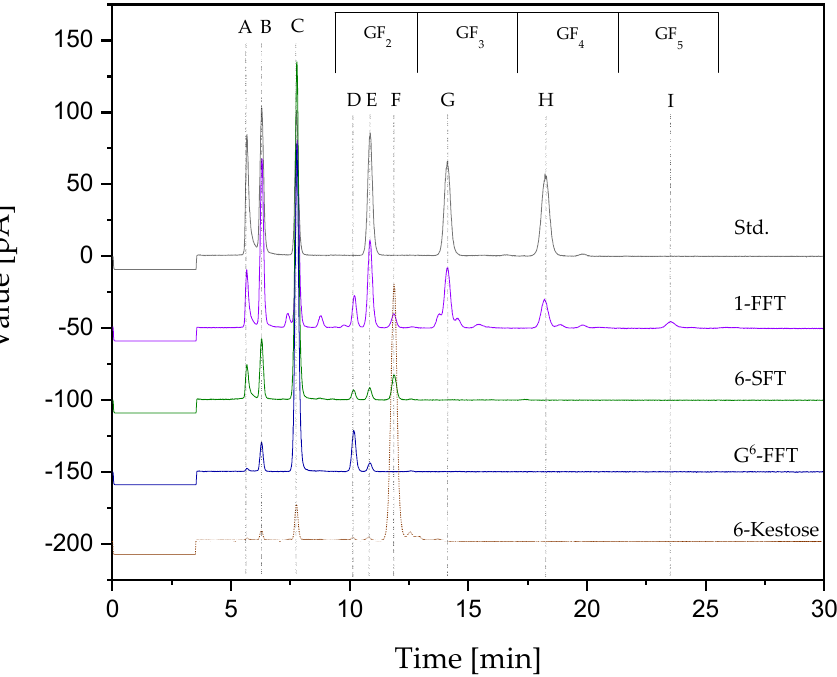
Figure 3. Chromatograms showing FOS standards and catalytic products. Offset = 50 pA between chromatograms. The peaks correspond to ( A ) fructose, ( B ) glucose, ( C ) sucrose, ( D ) neokestose, ( E ) 1-kestose, ( F ) 6-kestose, ( G ) nystose, ( H ) 1F-fructofranosylnystose, and ( I ) a putative FOS with five fructose molecules (GF 5 ). The chromatograms represent a standard solution (Std.), the catalysis products of 1-FFT, 6-SFT and G 6 -FFT and a 6-kestose sample.